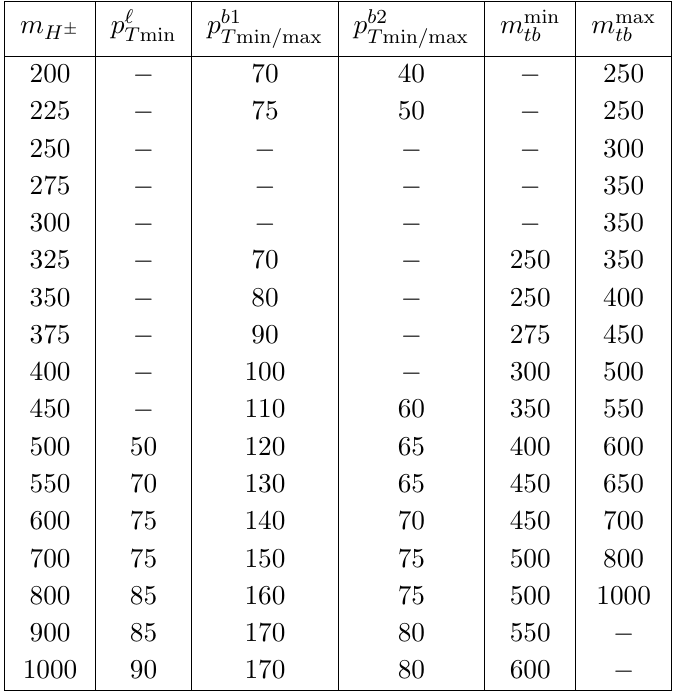
Table 1 . Bounds of kinematic variables in the mass range 200 GeV (cid:20) m numbers are in units of GeV. The symbol \ (cid:0) " indicates no cut being